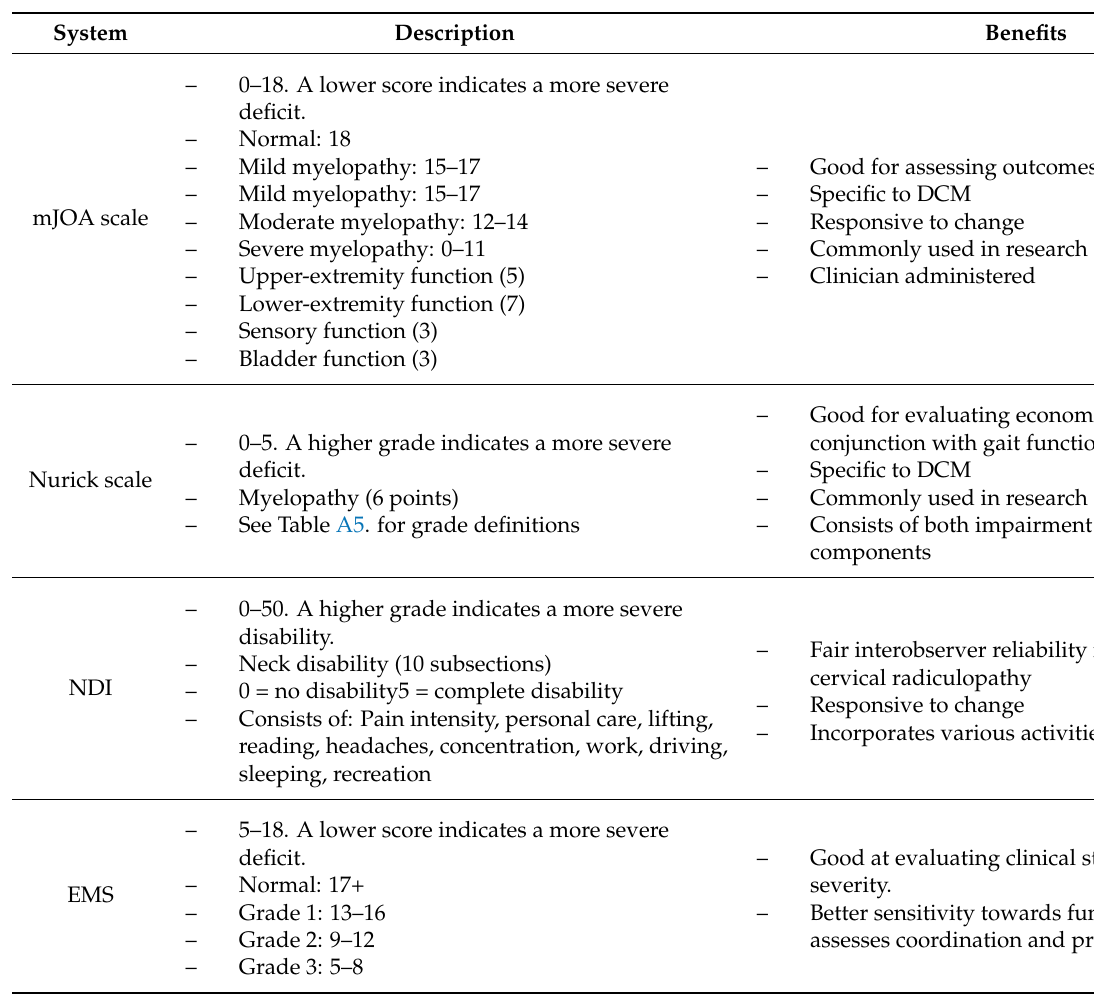
Table 2. Common classification systems used for DCM [17,47–56]. See Appendix A (Tables A1–A7.) for full scoring